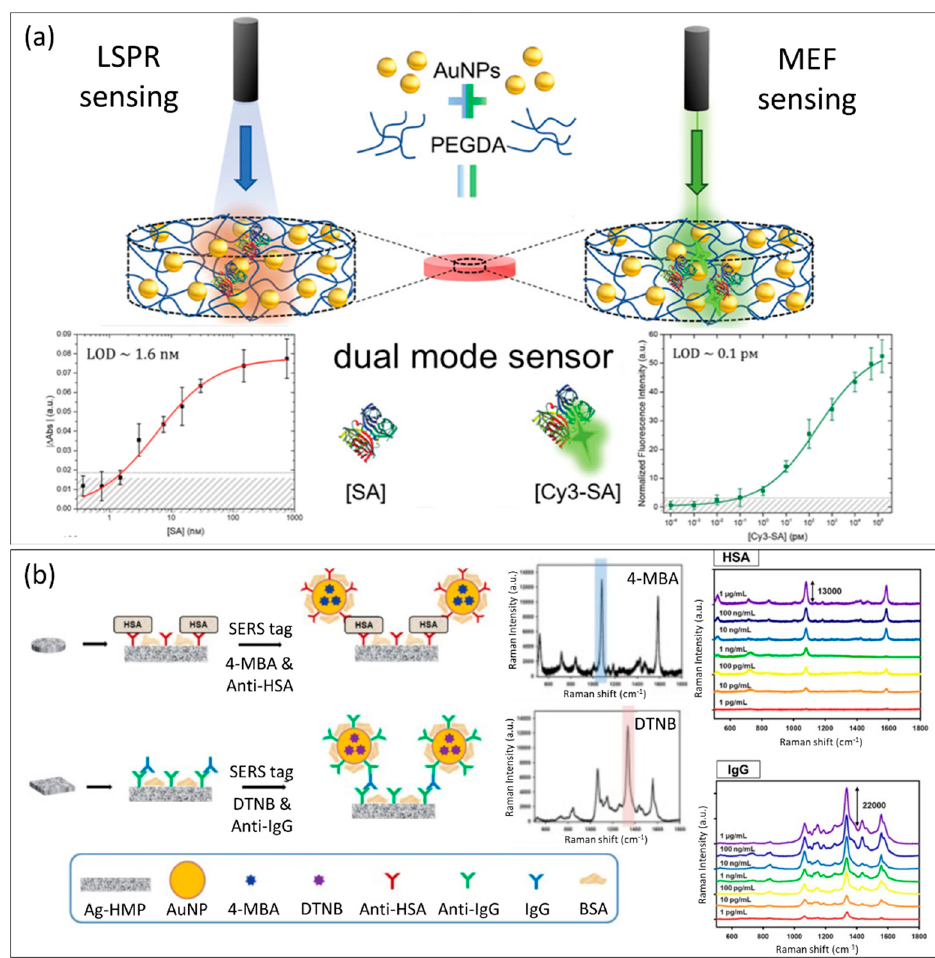
Figure 5. ( a ) Schematic representation of the dual mode plasmonic hydrogel transducer based on PEGDA and spherical gold NPs. On the left, the label-free sensing of streptavidin concentration [SA] is realized by absorption spectroscopy of the gold NPs functionalized with biotin. The absorbance variations as a function of the streptavidin concentration are due to the swelling of a high molecular weight hydrogel. On the right, the sensing of the Cy3-labeled streptavidin concentration [Cy3-SA] is realized by metal-enhanced fluorescence sensing mode. Adapted from Ref. [36]. Copyright (2022) The Authors. Advanced Materials Technologies published by Wiley-VCH GmbH.